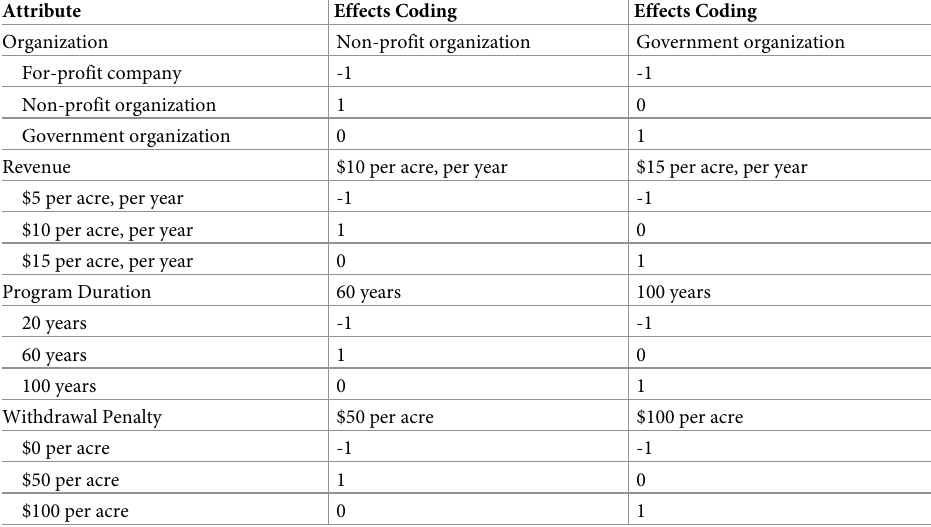
Table 3. Effects coding for analysis of best-worst scaling